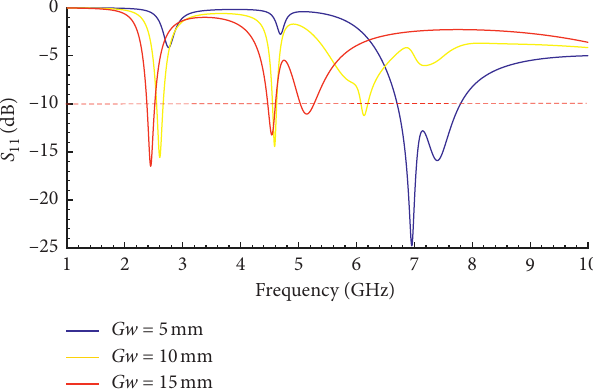
G w variation in Carica papaya